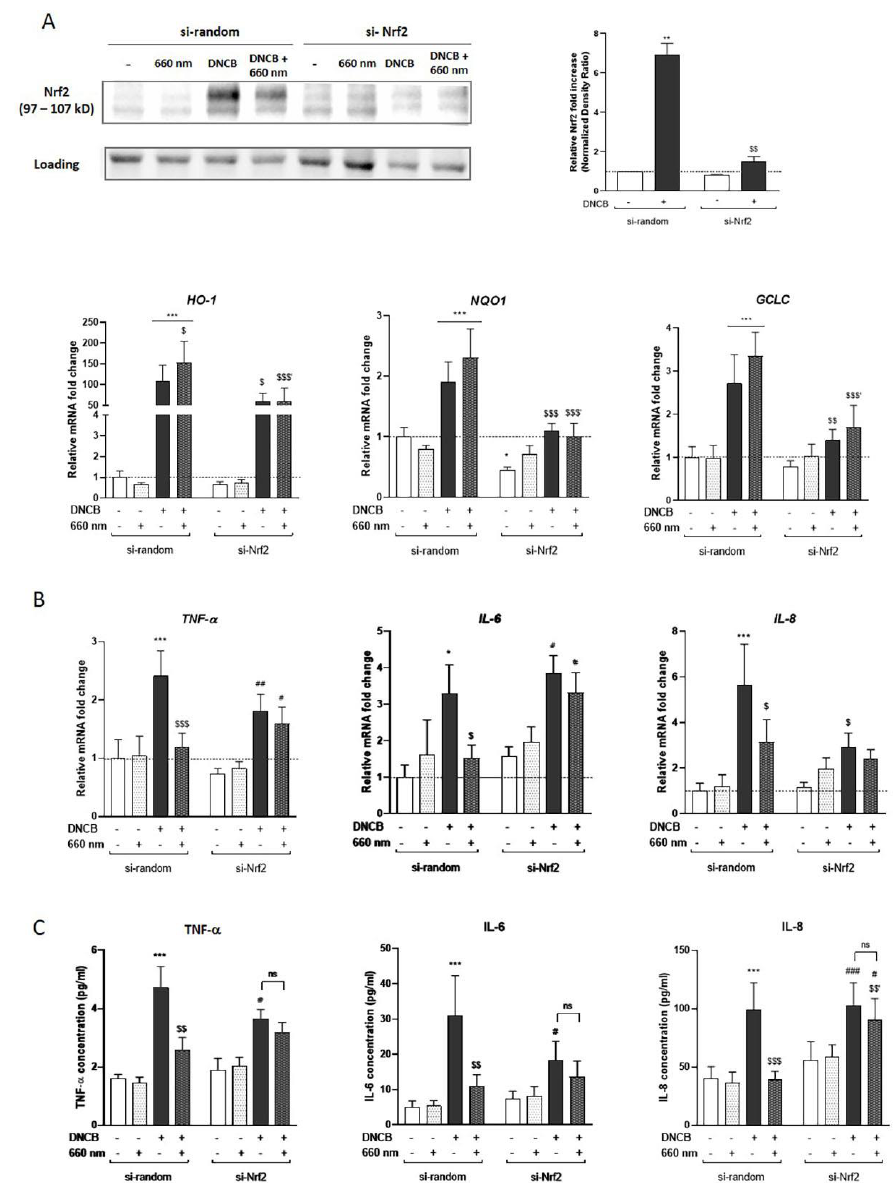
Figure 3. The anti-inflammatory effect of red light in KCs is Nrf2-dependent. KCs were transfected for 48 h by si-Nrf2 or si-random, and then treated with DNCB and exposed to red light. ( A ) Nrf2 accumulation in the knockdown model was assessed by Western blot 3 h after treatment. The blot is representative of 3 independent experiments. Histograms correspond to densitometric analysis relative to untreated si-random and are adjusted to the stain-free blot. Quantifying the expression of Nrf2 target genes encoding HO-1 , NQO1 , and GCLC in transfected KCs were assessed using RT-qPCR 3 h after treatment. Induction values were the ratio between gene expressions in treated cells versus gene expression in untreated si-random control. ( B ) Pro-inflammatory cytokines gene expression: TNF- α , IL-6 and IL-8 , were assessed by RT-qPCR, 3 h after light treatment. Results are expressed as fold change compared to the untreated si-random control. ( C ) The inflammatory cytokines level was determined by Meso Scaled Discovery technology in the supernatant of KCs after 6 h of exposure to DNCB with or without red light illumination. Reported data are mean ± SEM of 6 independent experiments. Two-Way ANOVA followed by Tukey post hoc test, * p < 0.05; ** p < 0.01; *** p < 0.001 vs. untreated si-random; $ p < 0.05; $$ p < 0.01; $$$ p < 0.001 vs. DNCB-treated si-random, $$ (cid:48) p < 0.01; $$$ (cid:48) p < 0.001 vs. DNCB + 660 nm-treated si-random; # p < 0.05, ## p < 0.01, ### p < 0.001 vs. untreated si-Nrf2. ns means non-significant